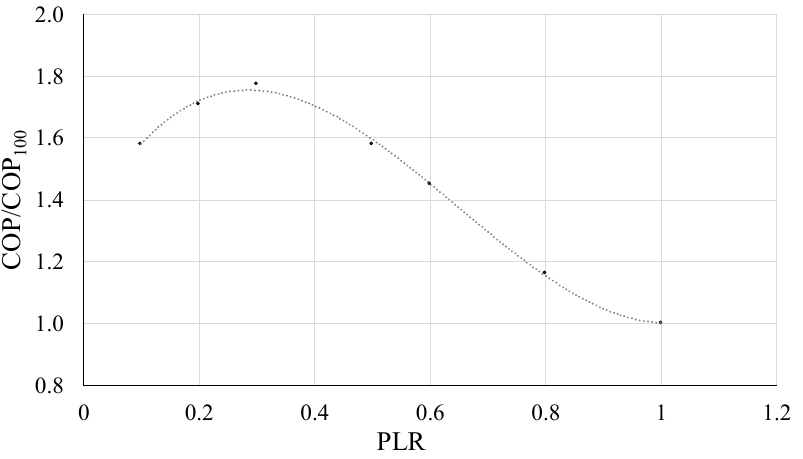
Figure 4. Ratio between the actual and nominal COP at different PLR values.